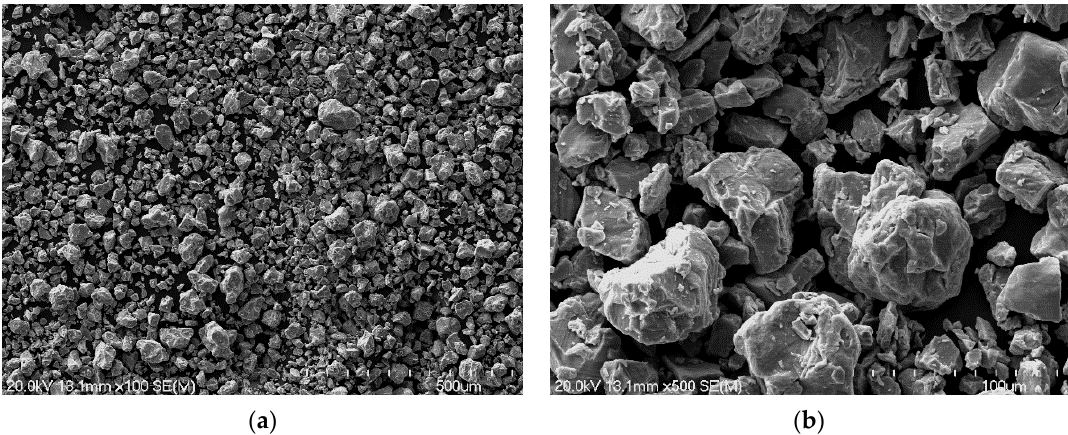
Figure 1. SEM images of the surface morphology of the titanium particles. ( a ) The titanium powders with irregular shape; ( b ) magnified morphology. Table 1. Chemical composition of the pure titanium powder